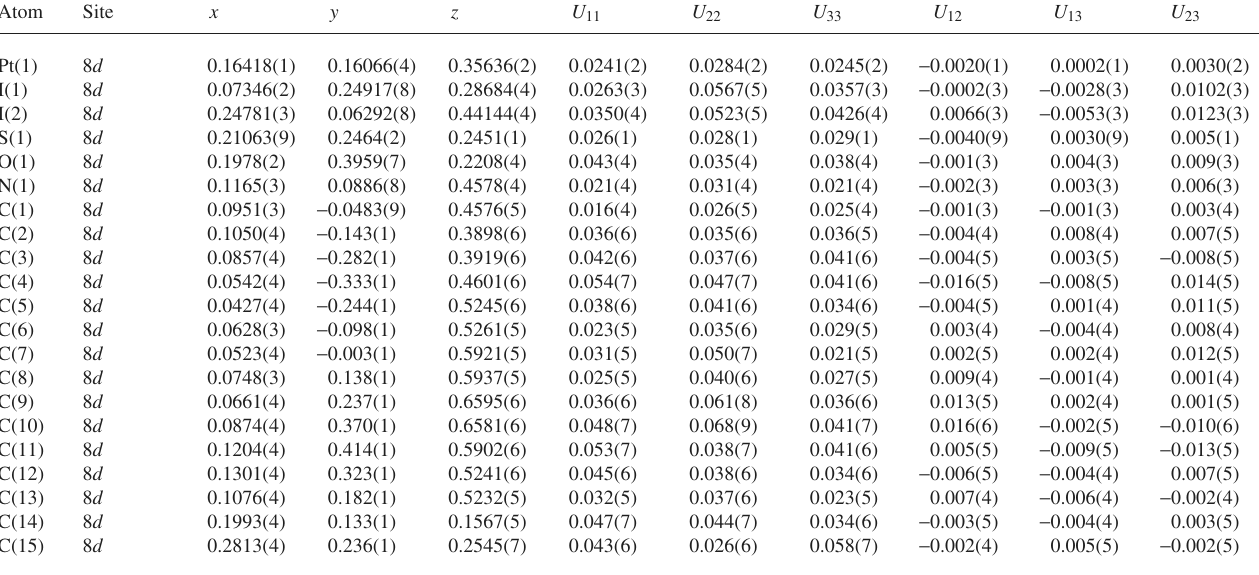
Table 3. Atomic coordinates and displacement parameters (in Å 2 ) .